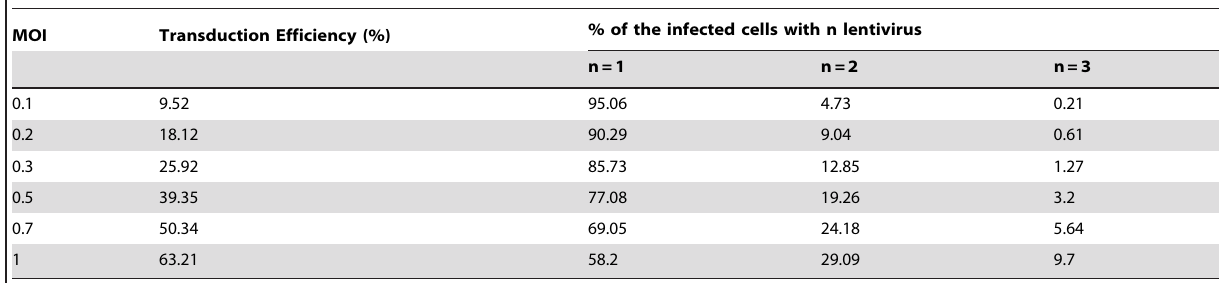
Table 2. Percentage of cells carrying n lentiviral insertions for a given MOI.